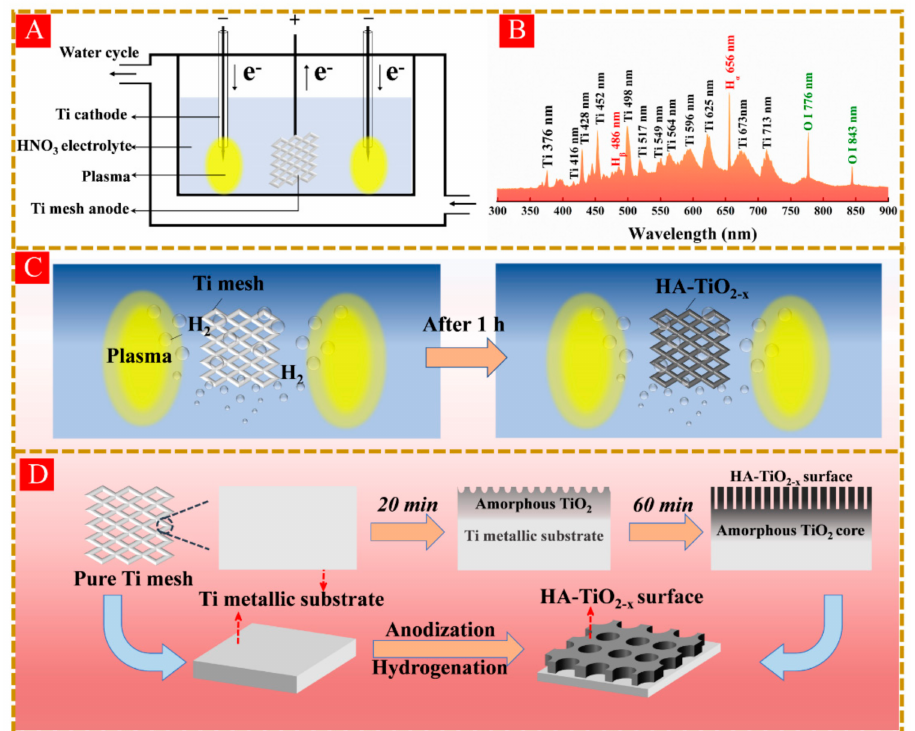
Figure 1. ( A ) the setup of synergistic treatment of liquid plasma induced hydrogenation and anodiza- tion. ( B ) the emission spectra of liquid plasma, and ( C ) the variations of surface color in Ti mesh. ( D ) schematic illustration of the preparation of HA-TiO 2 − x @Ti mesh